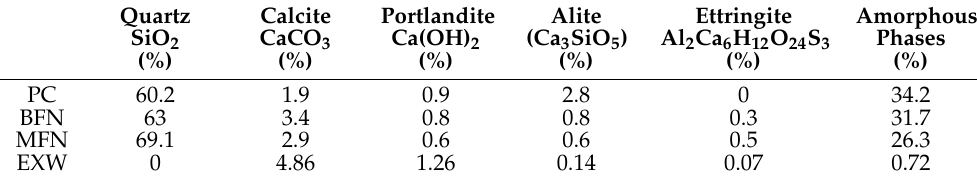
Table 8. Relative phase contents (%) from the XRD results by the Rietveld method.